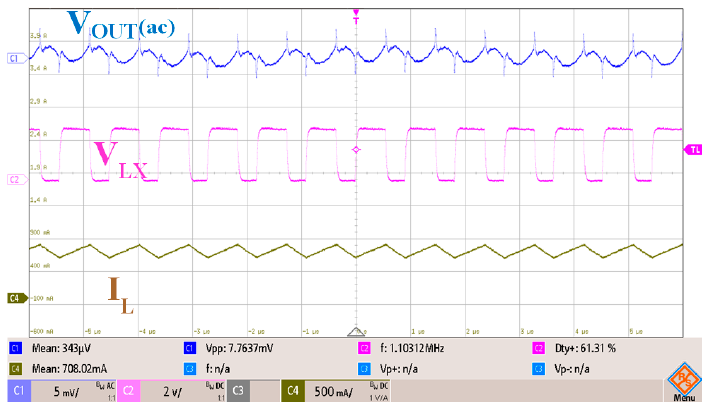
Figure 13. Measured heavy load output ripple of the proposed DC-DC buck converter ( V OUT = 1.8 V; I LOAD = 700 mA).